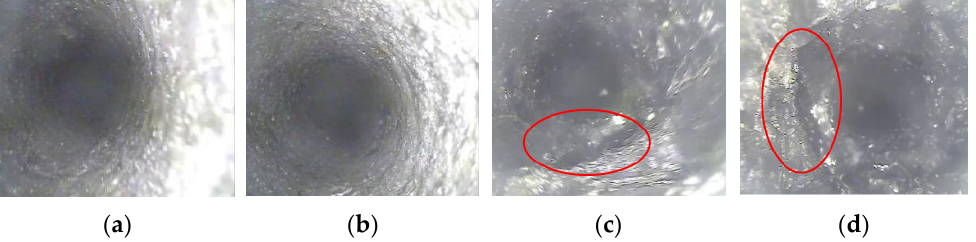
Figure 6. Drilling images of a borehole at different distances from coal pillar side of roadway. ( a ) 1.5 m. ( b ) 2.0 m. ( c ) 2.5 m. ( d ) 3.0 m.